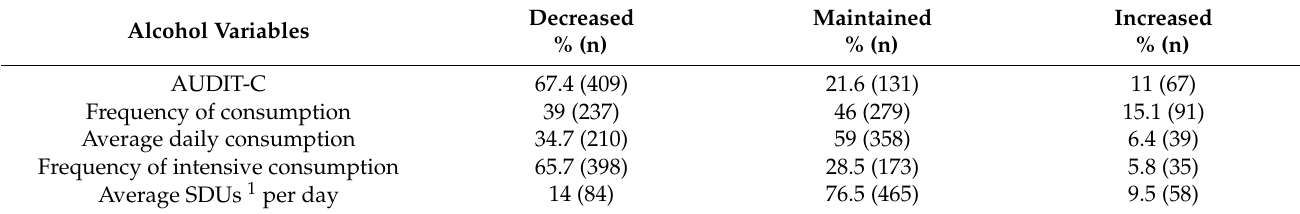
Table 4. Changes in alcohol consumption during confinement in risk consumers ( n = 607).